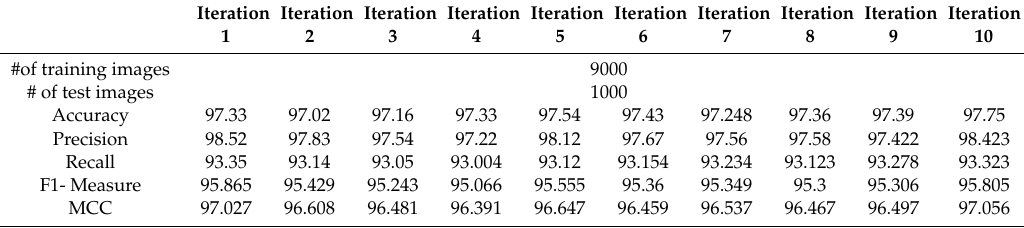
Figure 11. The 10-fold cross-validation average result on DVMM using the proposed model. Table 6. The detailed results of 10-fold cross-validation on the NIST 17 dataset using the proposed model.